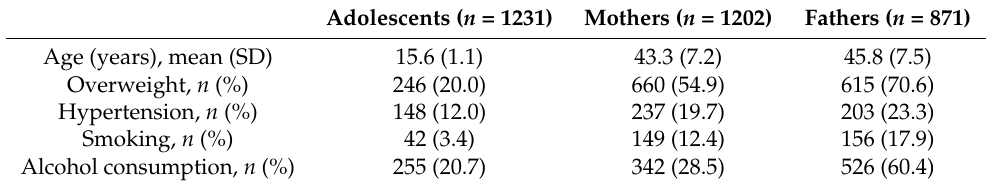
Table 1. Sample characterization.